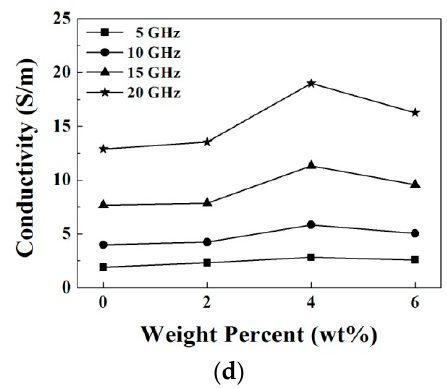
Figure 9. ( a ) Dielectric constant; ( b ) conductivity; ( c ) increment variation of the dielectric constant, and ( d ) increment variation of the conductivity of the prepared samples as functions of the doping concentrations of lignin.